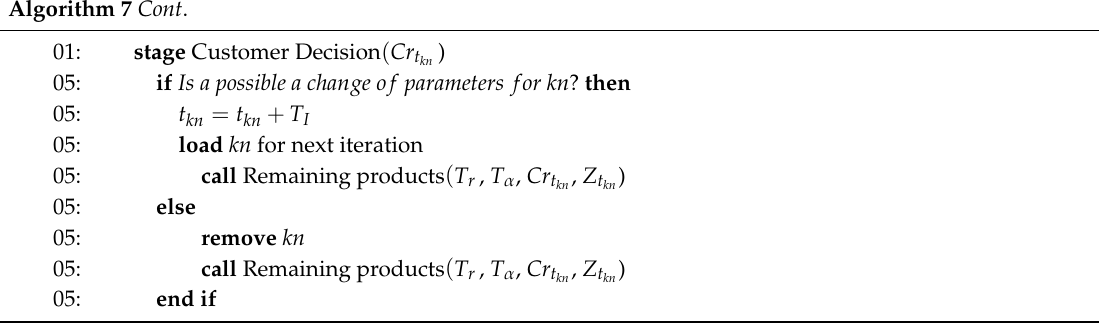
Algorithm 7 Cont